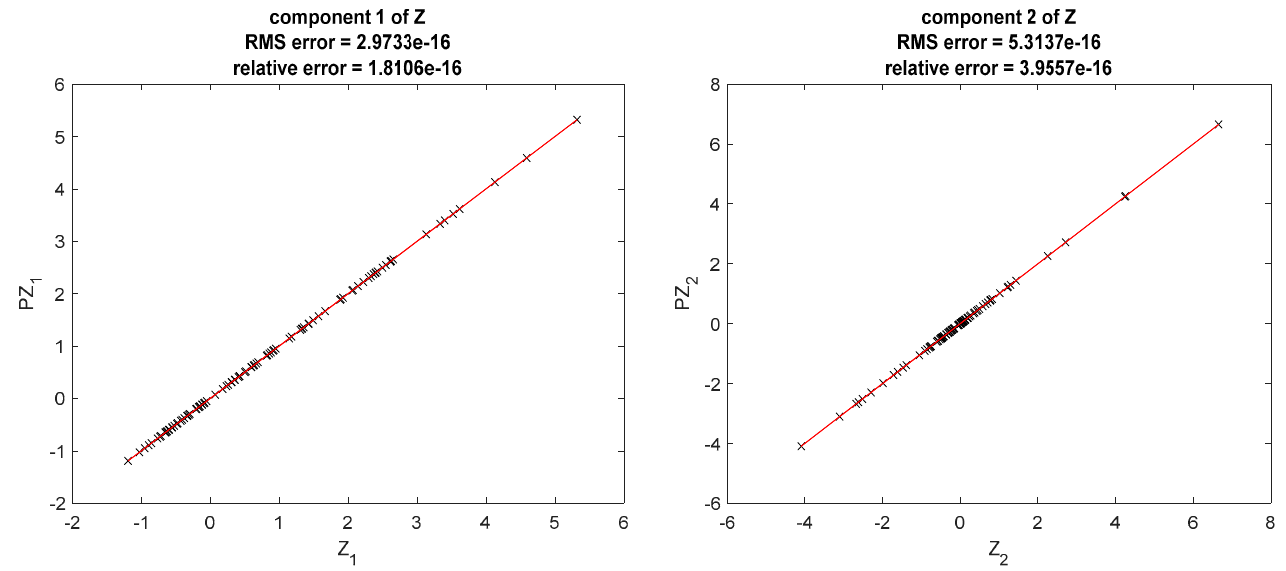
Figure 1. Results obtained in the first example. Points marked on the graphics correspond to ( Z ( S ) , PZ ( S )) . Close results correspond to points close to the bisector of the quadrant. RMS errors are inferior to 1 × 10 − 15 .